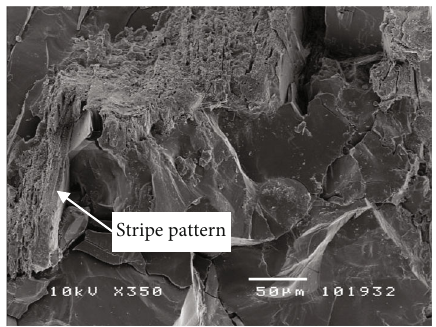
Figure 17: Stripe pattern (-30 ° C, × 350).